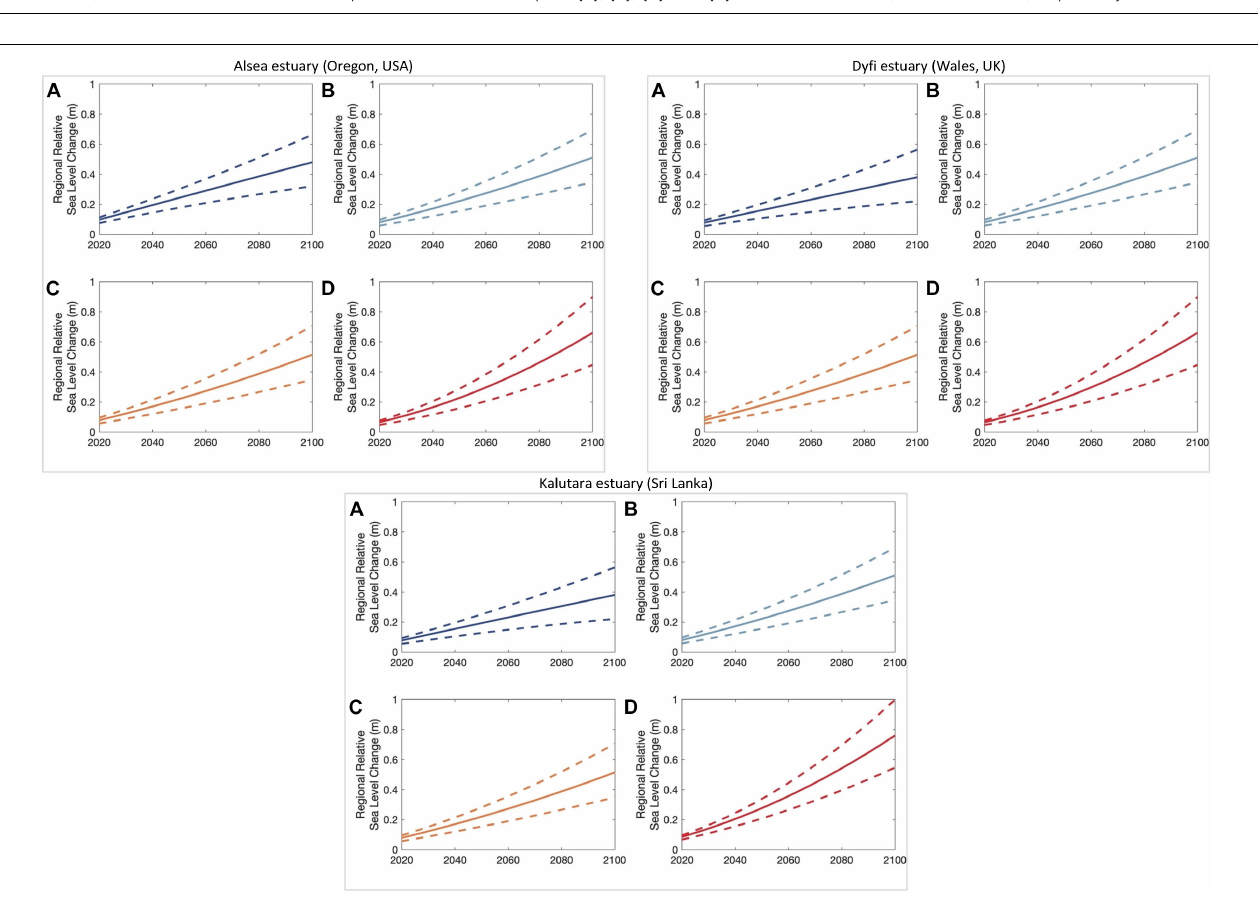
The empirical CDF plots in Figure 7 -Panel I indicate the total uncertainties associated with the projected (cid:49) V T at the Alsea estuary system (in contrast to the selected range between